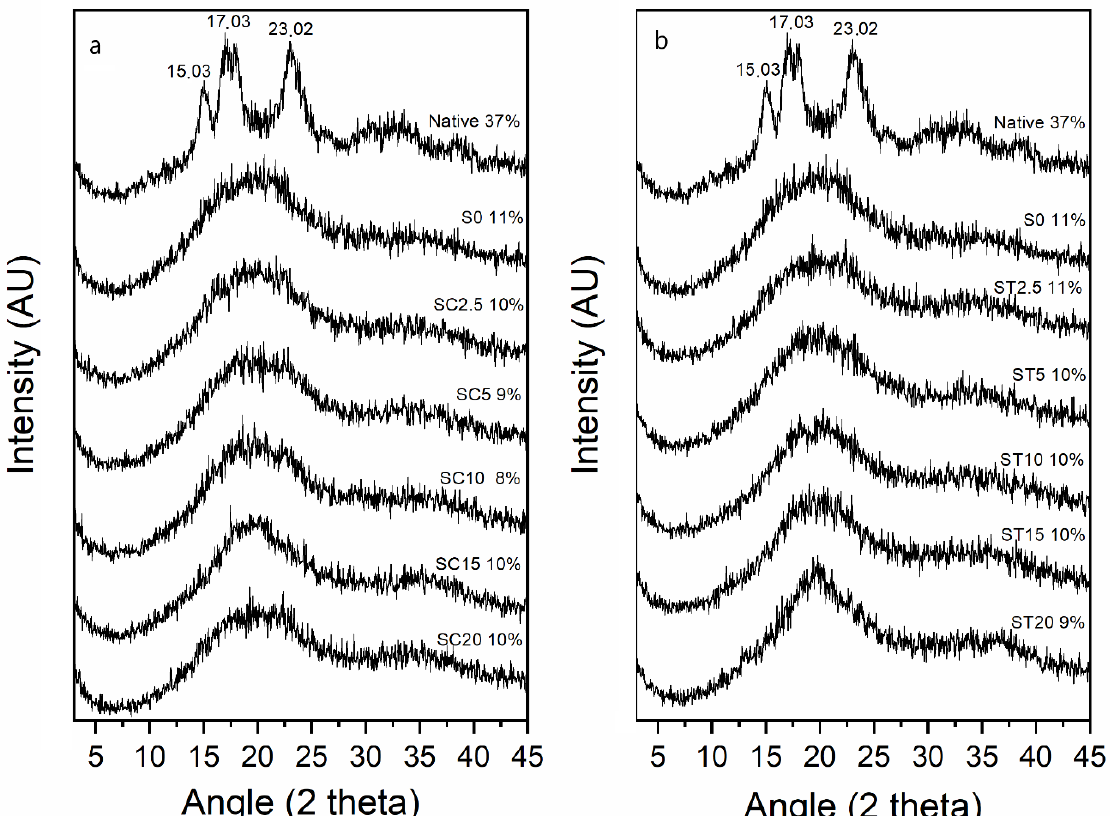
Figure 2. X-ray diffraction (XRD) patterns and relative crystallinity index (CI) of native starch, the control sample (extruded without reagent—S0) and starch hydrogels obtained by reactive extrusion through reaction with CA ( a ) and TA ( b ).